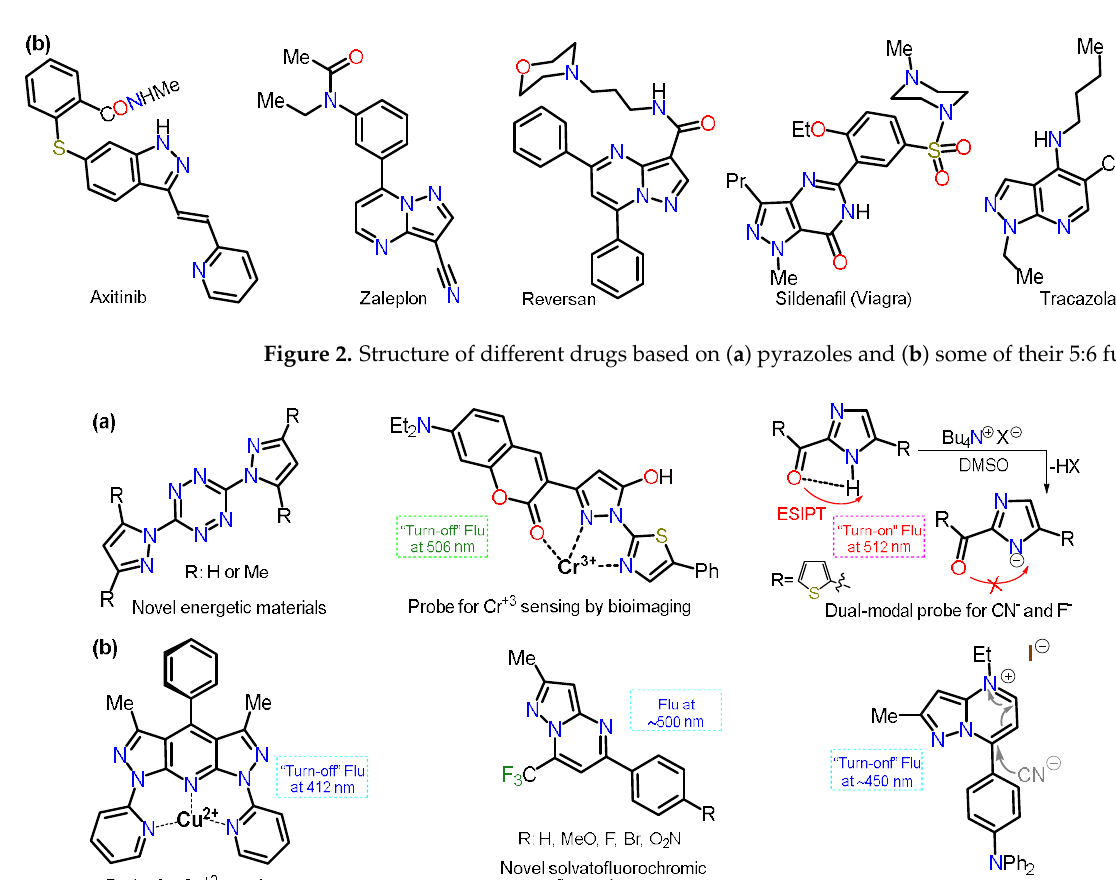
Figure 3. Physically relevant molecules based on ( a ) pyrazoles and ( b ) their fused